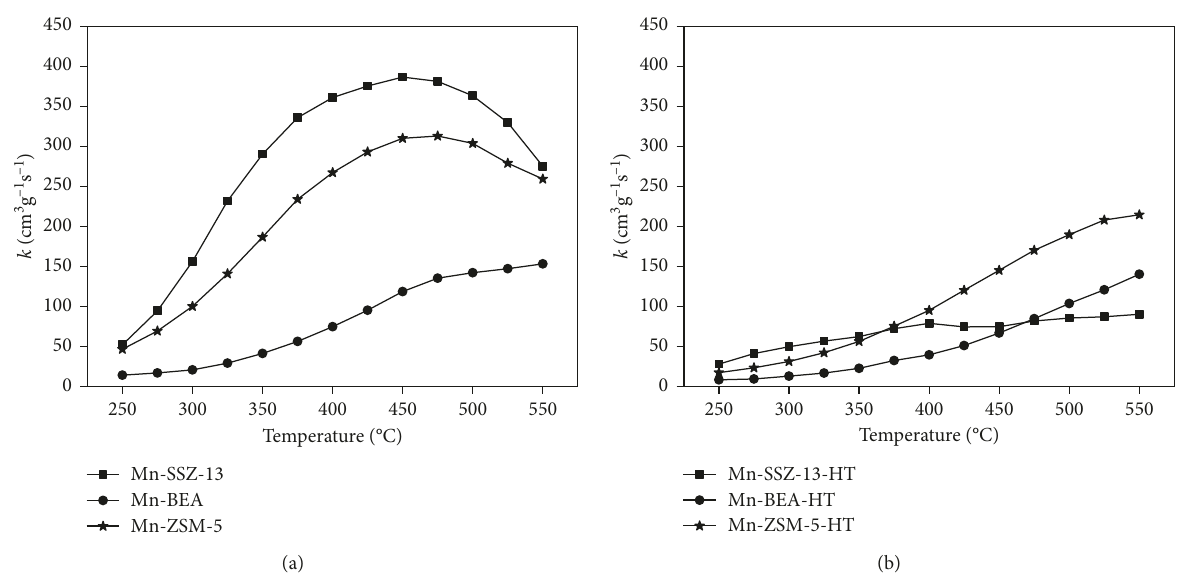
Figure 6: SCR activity of (a) fresh and (b) hydrothermally treated